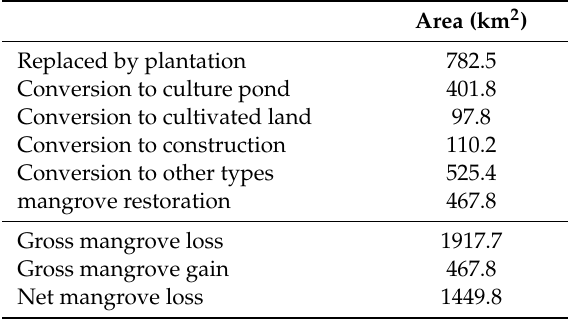
Table 6. Mangrove cover and change from 1988 to